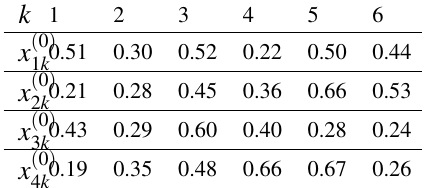
of W , W i , i = 1 , 2 , 3 , 4 from June to December in i